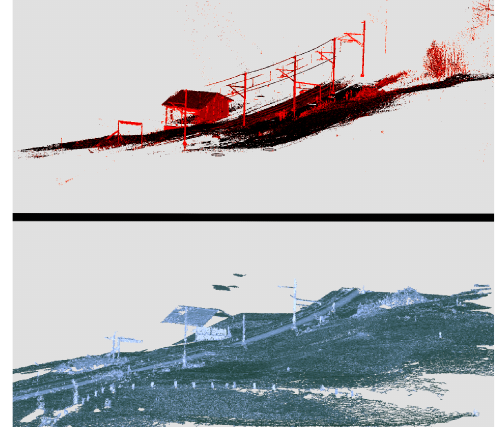
Figure 1: Differences in detail. Top: Laser scan point cloud, Bottom: Photogrammetric point